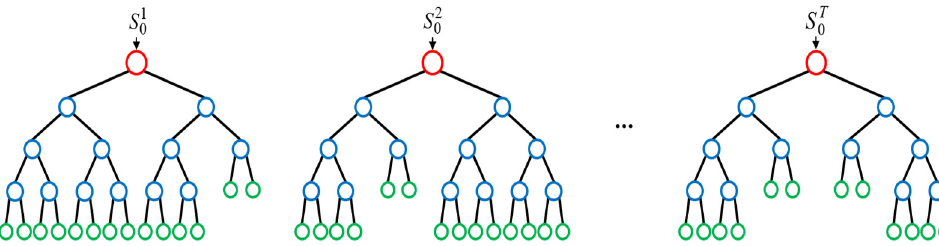
Figure 2. Typical architectures of bagging.